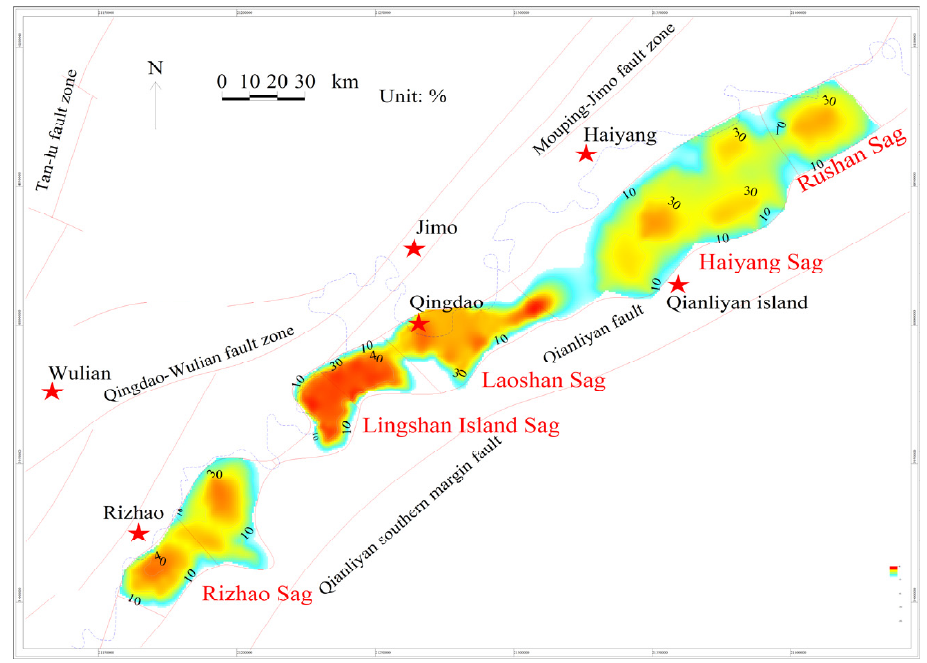
Figure 3. Contour map of the mudstone/strata ratio of the Laiyang Formation in the Ri-Qing-Wei Basin.